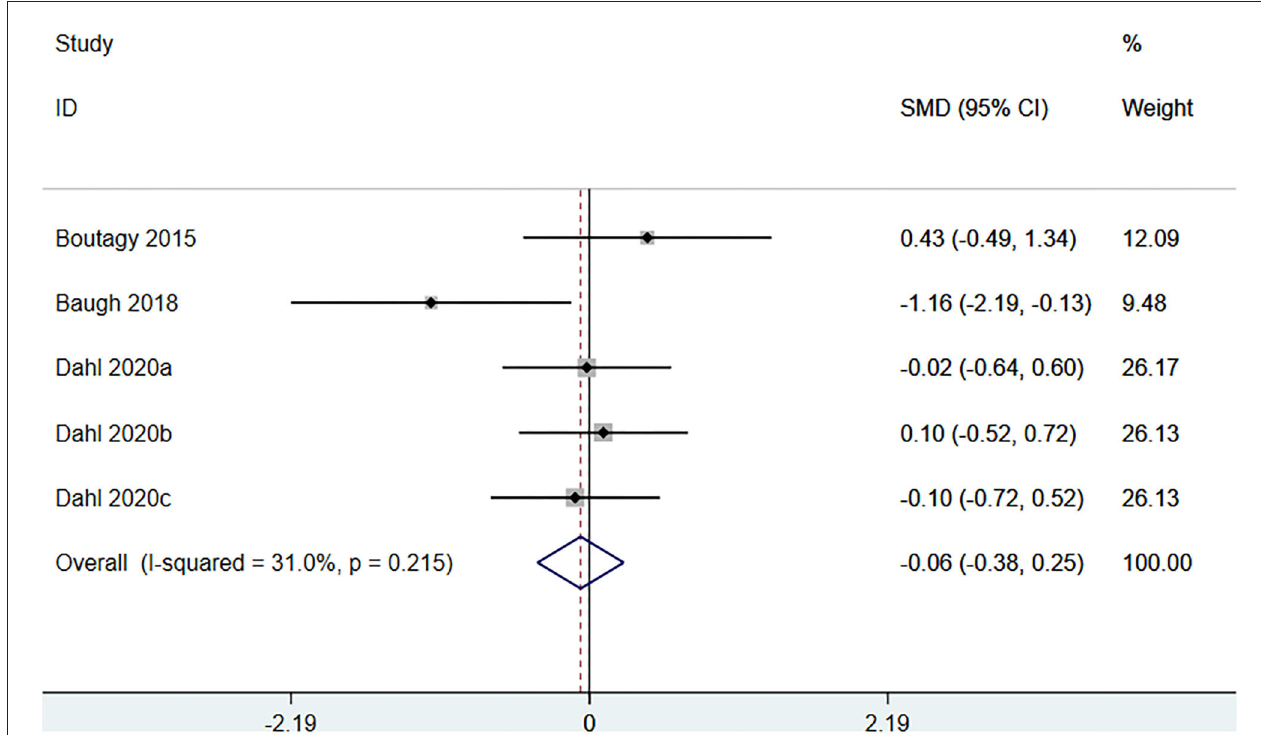
FIGURE 11 | Forest plot for the effect of microbiota-driven therapy on circulating L-carnitine level. The effect size of each trial or the overall was represented as black diamond and the weight of each trail in the overall study was represented as gray box around black diamond. The estimated 95% confidence interval of effect size was identified by extending lines. CI, confidence interval; RCT, randomized controlled trial; SMD, Standard Mean